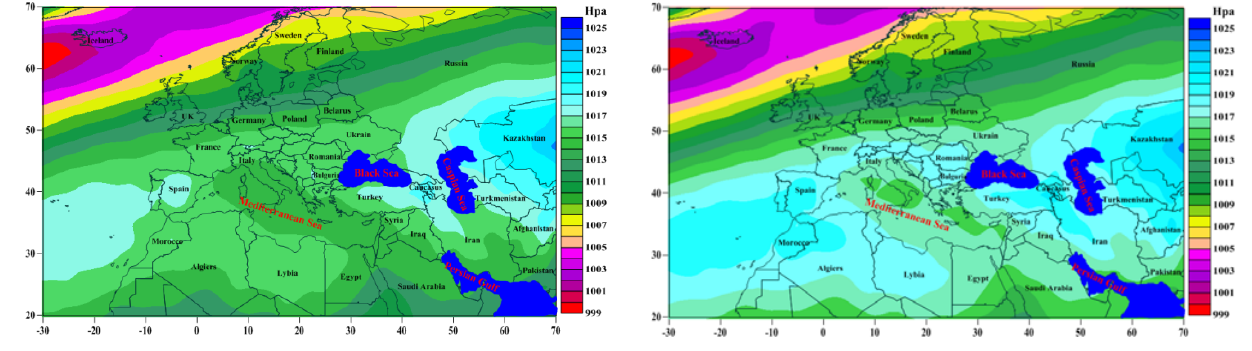
Fig. 8. Synoptic Pattern of Caucasian High Pressure Fig. 9. Synoptic Pattern of Caucasian Strong High